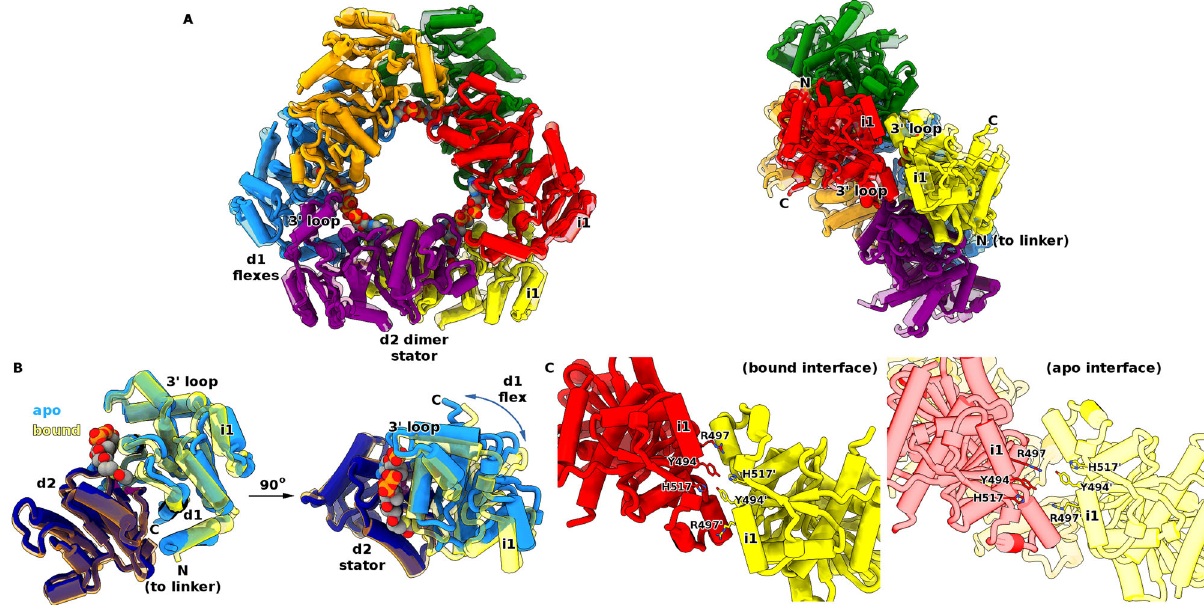
Fig. 4 Conformational change between the bound and apo forms of the MaeB PTA domain. A Overlay of the acetyl-CoA PTA bound (non-transparent) and PTA apo (transparent) structures, viewed from front and side. The d2:d2 dimer interface at the triangle middle edge acts as a stator where the d1 subdomain fl exes relative to this, driven by shifts at the ligand-sensing 3 ′ loop at the d1:d1 interface (helix labelled i1 contributing Y494 and R497). B Demonstration of fl exation in a single PTA monomer, from two orthogonal views. Acetyl-CoA “ attracts ” the 3 ′ loop, reducing the d1:d2 distance in the bound state (yellow d1/orange d2) relative to the apo form (light blue d1/dark blue d2). The d1 subdomain “ rocker ” movement (labelled d1 fl ex) transmits ligand occupancy at the 3 ′ loop to the interface (i1). Importantly the PTA N-terminal helix (linking to ME domain in full-length protein) shifts between the two states. C Zoomed-in view of isolated PTA apo and PTA bound d1:d1 interfaces, viewed from same orientation as that in ( A ) superimposition above. The interface helices shear relative to one another as the hexamer fl exes, altering interactions between Y494, R497 and